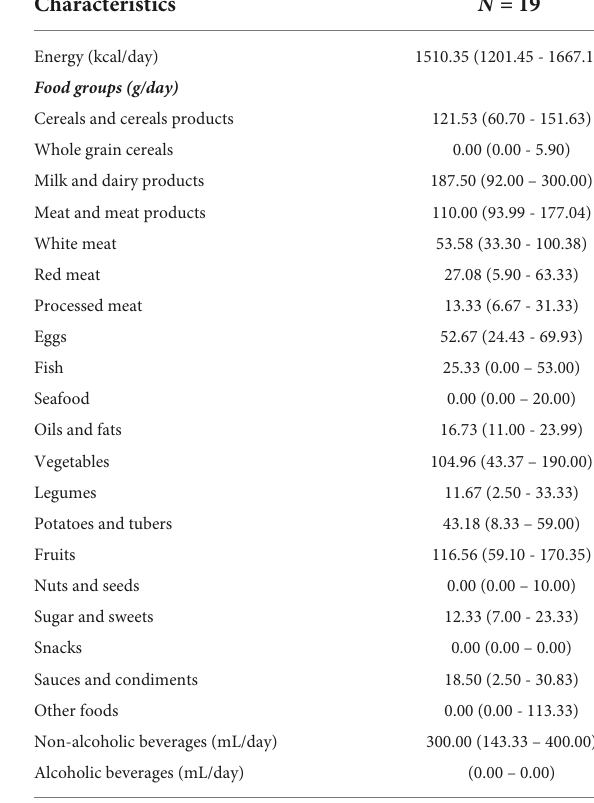
TABLE 2 Description of the energy and food groups intake in the sample of